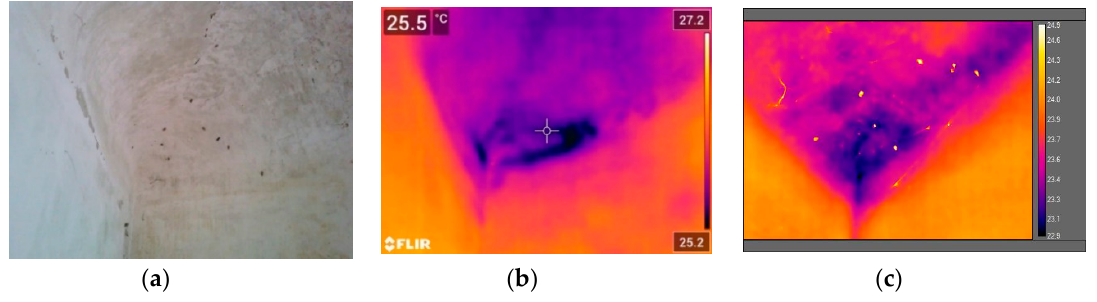
Figure 4. (Left to right) the set of images represent adjacent inside corner of the lower ground oval eastern room area. ( a ) Is the visual image of the area, ( b ) is the thermal image taken during the survey in August 2019, ( c ) is the thermal image taken during the survey in February 2020.